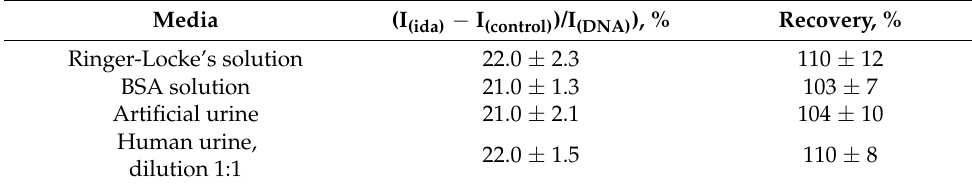
Table 1. Determination of 1 pM idarubicin in spiked samples of various media mimicking serum, blood plasma, in artificial and human urine by cyclic voltammetry method. Mean ± S.D. for six individual sensors.